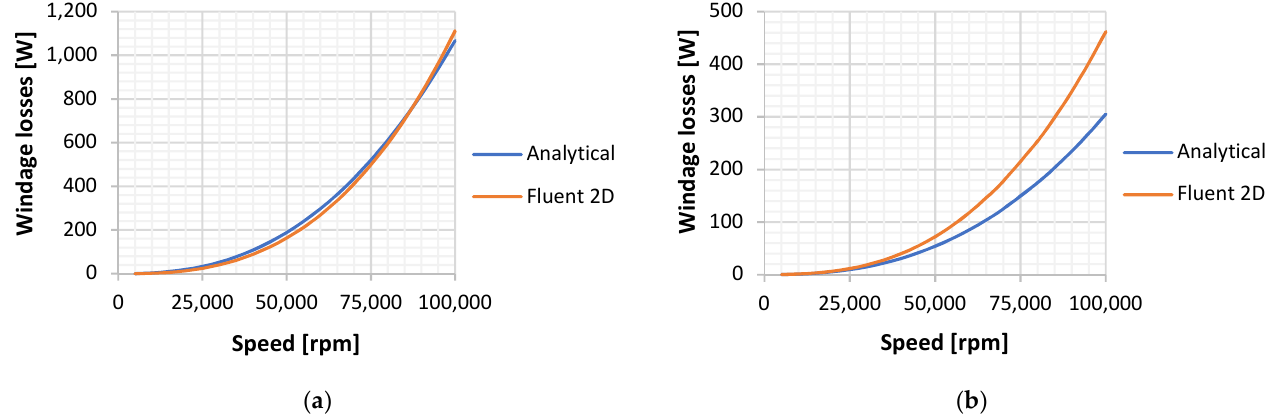
Figure 17. Comparison of windage losses for different speeds: ( a ) salient poles, ( b ) smooth cylindrical rotor.